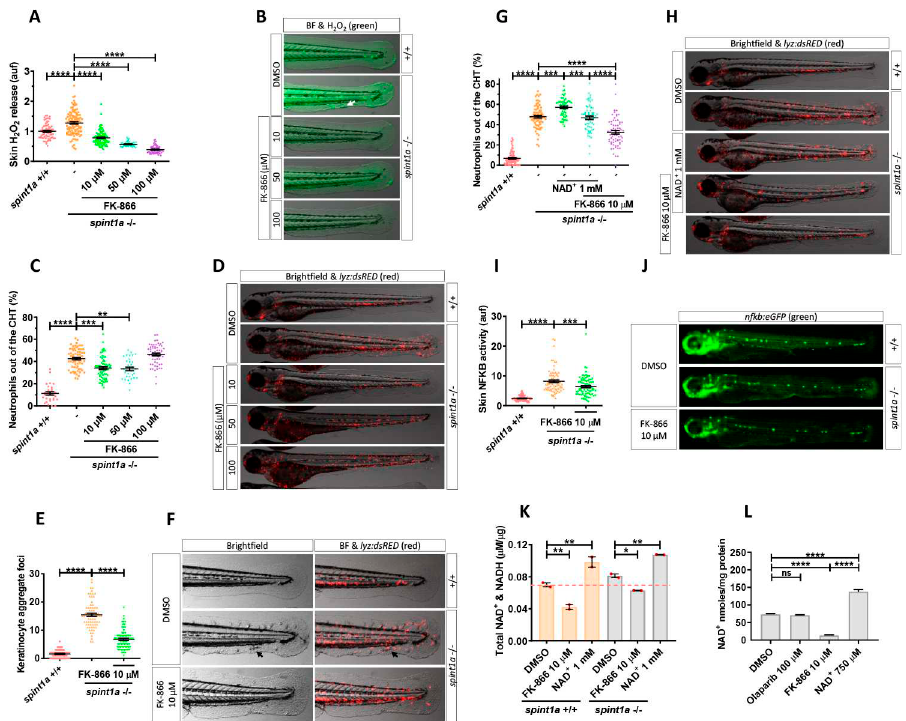
Fig 2. Pharmacological inhibition of Nampt alleviates stress and skin inflammation in Spint1a-deficient larvae. (A) Quantification of skin H 2 O 2 production in wild-type and Spint1a-deficient zebrafish larvae treated with FK-866 (0, 10, 50, and 100 μ M). (B) Representative merge images (brightfield and green channel) of zebrafish larvae of every group are shown. The white arrow indicates a keratinocyte aggregate where H 2 O 2 release was high. (C) Neutrophil distribution of wild-type and Spint1a-deficient zebrafish larvae treated with increasing doses of FK-866. (D) Representative merge images (brightfield and red channel) of lyz : dsRED zebrafish larvae of every group are shown. (E) Number of keratinocyte aggregates in the tail skin of larvae treated with 10 μ M FK-866. (F) Detailed representative merge images (brightfield and red channel) of the tail of wild-type and Spint1a-deficient larvae treated with vehicle (DMSO) or 10 μ M FK-866. Black arrows indicate keratinocyte aggregates and immune cell recruitment presents in nontreated Spint1a-deficient skin. (G) Neutrophil distribution of zebrafish embryos treated with 1 mM NAD + in the presence or absence of 10 μ M FK-866. (H) Representative merge images (brightfield and red channels) of lyz : dsRED zebrafish larvae of every group are shown. (I) Quantification of fluorescence intensity of wild-type and Spint1a- deficient embryos treated with 10 μ M FK-866. (J) Representative images (green channel) of NF-kB : eGFP zebrafish larvae of every group are shown. (K) Wild-type and Spint1a-deficient larvae of 72 hpf treated for 48 hours with 10 μ M FK-866 and 1 mM NAD + were used for total NAD + and NADH determination by ELISA. (L) Spint1a-deficient larvae of 72 hpf treated for 48 hours with 100 μ M olaparib, 10 μ M FK-866 and 750 μ M NAD + were used for NAD + determination by enzymatic cycling method. Each dot represents one individual, and the mean ± SEM for each group is also shown. p -Values were calculated using 1-way ANOVA and Tukey multiple range test. ns, not significant, �� p � 0.01, ��� p � 0.001, ���� p � 0.0001. The data underlying this figure can be found in S1 Data. ANOVA, analysis of variance; NAD+, nicotinamide adenine dinucleotide; Nampt, nicotinamide